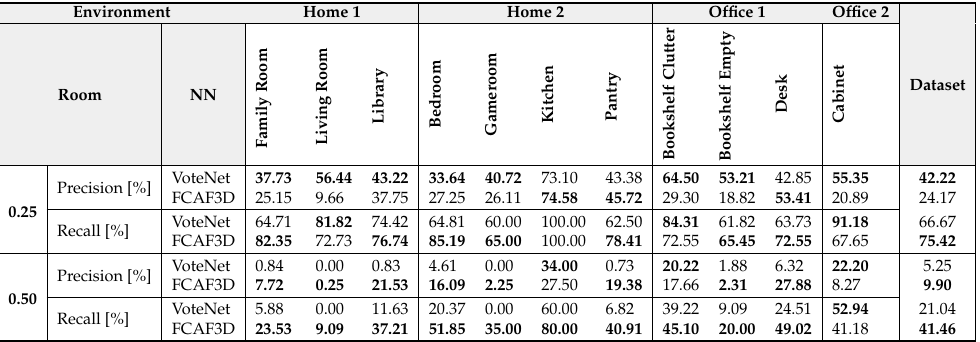
Table 6. Results of evaluation of the storage volume detectors on the real dataset. Bold values represent higher precision or recall, which indicates a better